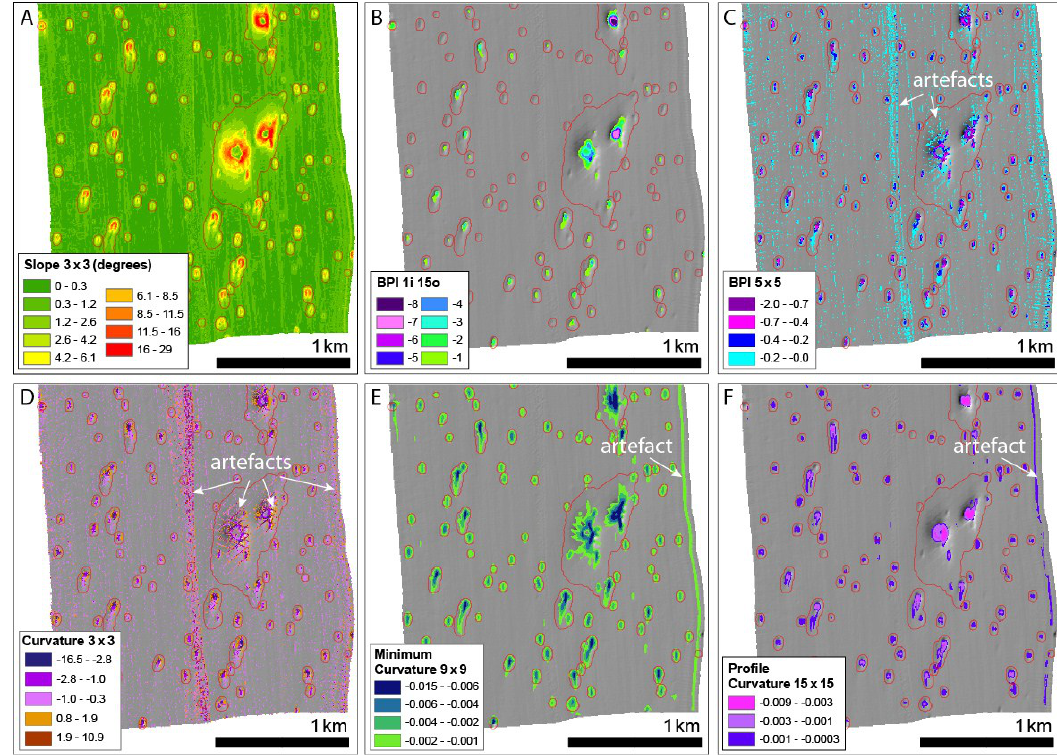
Figure 13. Examples of pixel-based terrain attributes from the southern part of SEA2 Box 4. Background data—greyscale shaded relief image of bathymetry data. Pockmark features delineated by the BGS Mapping toolbox are shown in red for reference. All terrain attributes except ( B ) are coloured according to natural breaks classification and no colour is used for irrelevant classes, where appropriate, to aid visualisation. ( A ) Slope calculated in ArcGIS Spatial Analyst using standard 3 × 3 rectangular neighbourhood; ( B ) BPI (integer) using the BTM toolbox using annulus neighbourhood with an inner radius of 1 and an outer radius 5; ( C ) BPI (floating point) calculated using a 5 × 5 rectangular window—negative BPI values correspond to negative features (depressions) in the seabed, including pockmarks, positive features (BPI value > 0) are not shown. Note that values in the range −0.2–0 (cyan) highlight numerous small artefacts in the data in addition to the shallower portions of pockmarks; ( D ) Curvature calculated using ArcGIS Spatial Analyst using standard 3 × 3 rectangular neighbourhood—values from − 0.3 to 0.6 (close to flat) are not coloured. ( E ) Minimum Curvature calculated using a 9 × 9 rectangular neighbourhood—values greater than − 0.001 are not coloured; ( F ) Profile curvature calculated using a 15 × 15 rectangular neighbourhood—values greater than − 0.0003 are not coloured (flat and positive features). Note that visual interpretation of the results, and the extent to which features and artefacts show up is very dependent on the colour ramp used. These figures are intended as examples only.